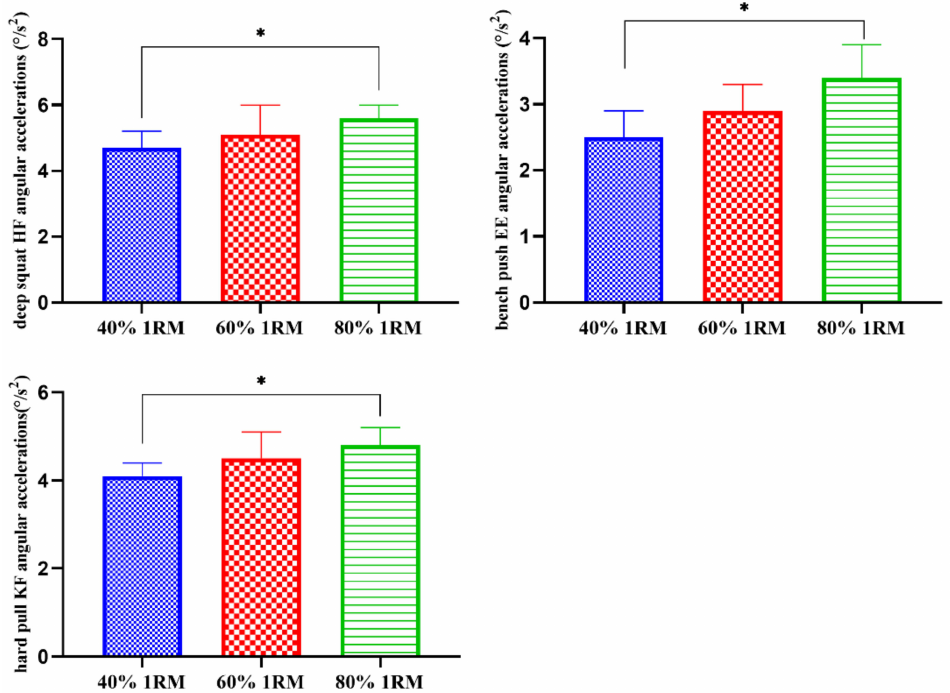
Figure 6. Comparisons of the different load intensity test angular accelerations ( ◦ /s 2 ). * There was a significant difference between 40% 1RM and 80% 1RM ( p <